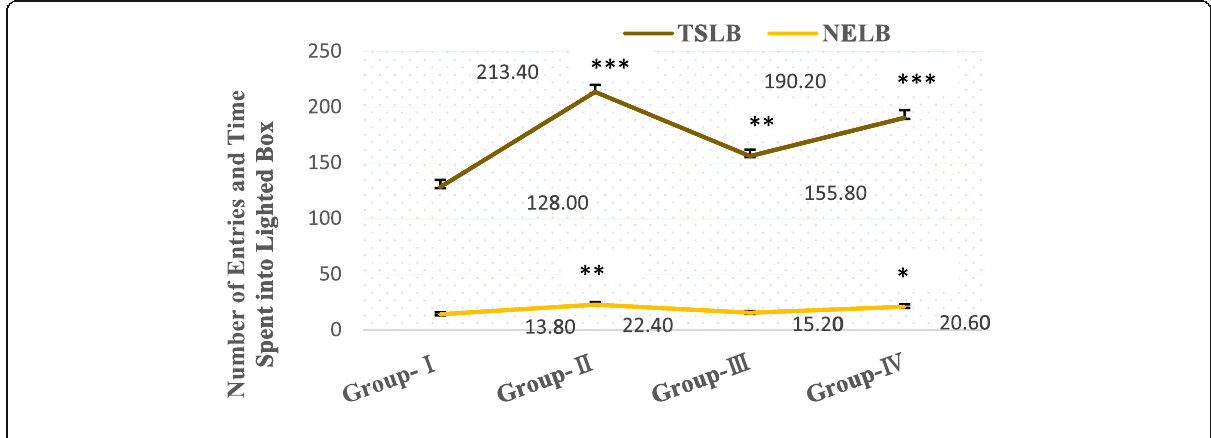
Fig. 2 Effect of Psidium guajava Linn leaves extract on time spent and number of entries into bright illuminated part in light and dark model transition test. Group I = control group, group II = positive control group, group III = Psidium guajava Linn low strength group, group IV =